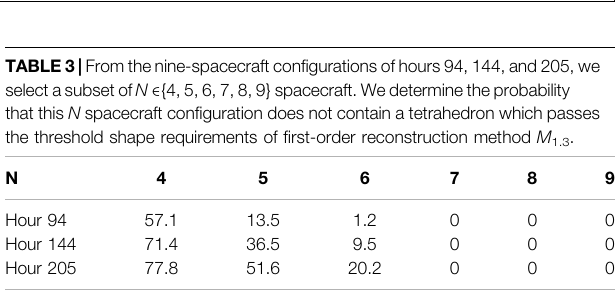
FIGURE 11 | Computation error (de fi ned in Eq. 7 ) at all points on the z (cid:1) 0 plane of the turbulent magnetic fi eld (from the Gkeyll Simulation), using the fi rst-order method M 1,3 with a subset of the spacecraft from the hour 94 con fi guration of the HelioSwarm DRM.